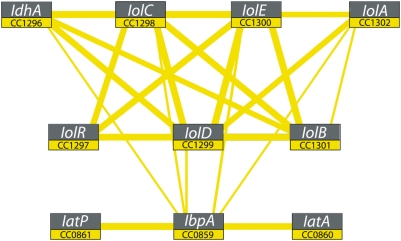
Computational prediction of the myo-inositol module in C. crescentus.A probabilistic network of protein associations constructed from coexpression, coinheritance, colocation, and coevolution data from C. crescentus
[34] predicts that genes at two disjoint chromosomal loci (CC0859–CC0861 and CC1296–CC1302) are functionally associated (i.e. these genes are predicted to be part of the same KEGG pathway [45] or GO process [46]). Genes are shown as nodes and associations as edges, with edge widths denoting the strength of association (confidence interval for narrow lines is 30–60%; confidence for thick lines is >60%).